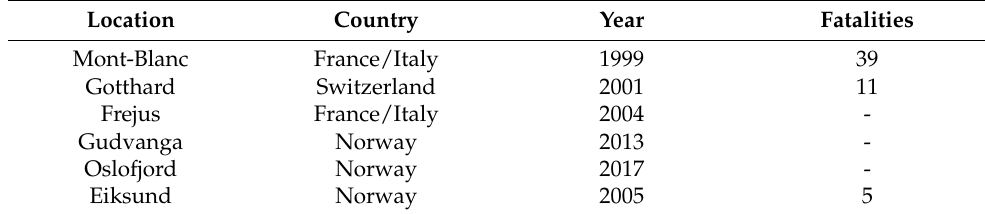
Table 1. A summarized list of fires in road